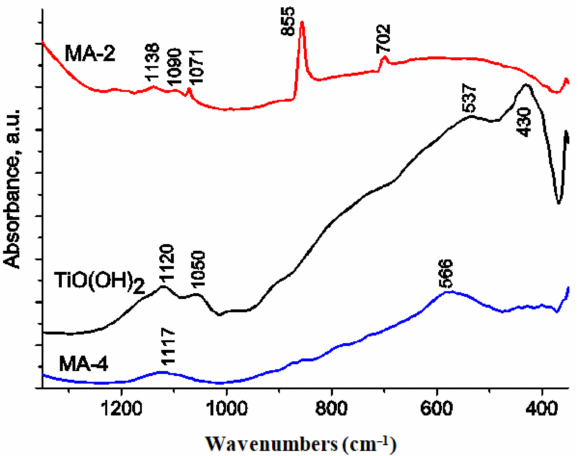
Figure 4. FT-IR spectra (fragment) of the initial SrO, MA-3 and MA-4 after mechanical activation for 10 min.